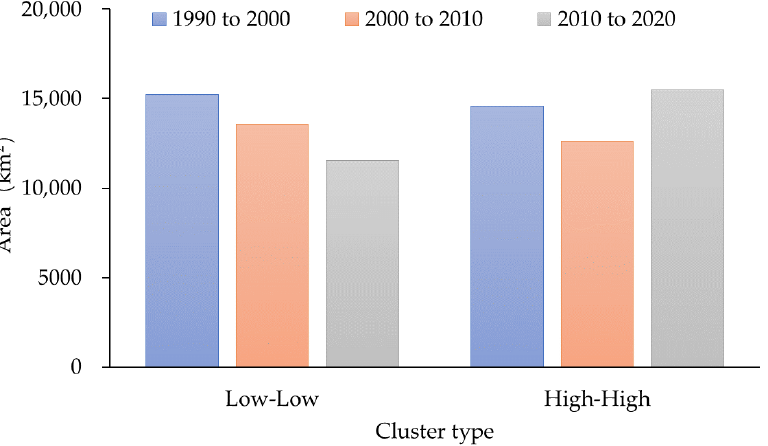
Figure 10. Area changes in high–high clustering and low–low clustering in different